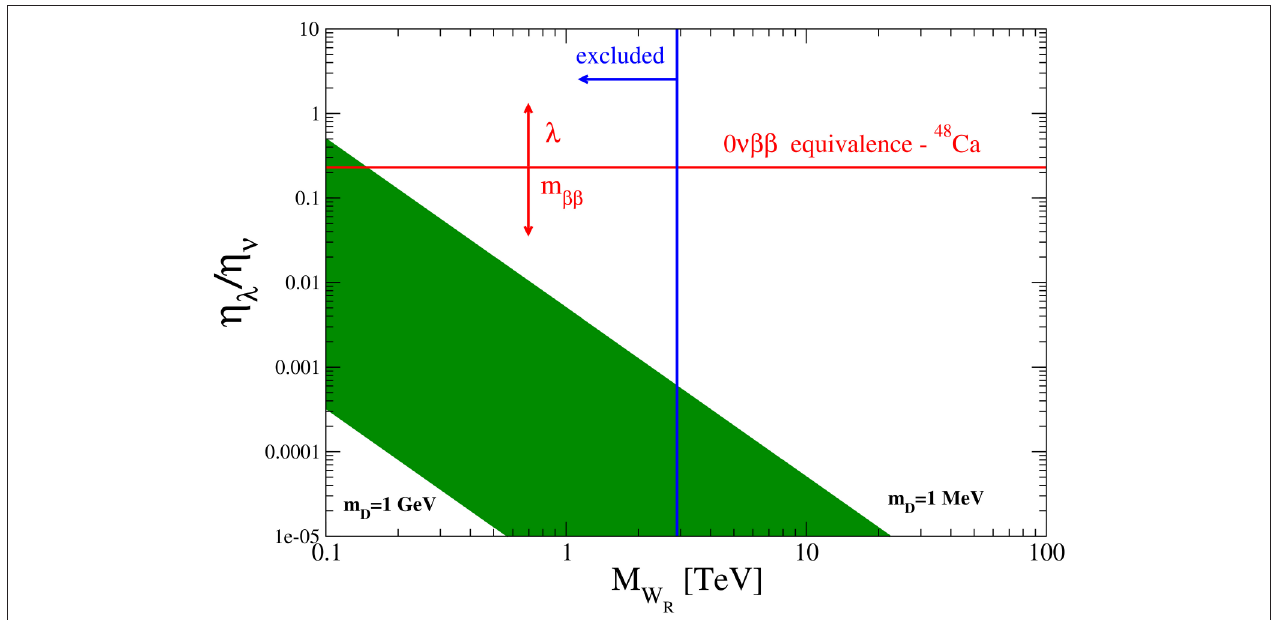
. The line of the 0 νββ equivalence R